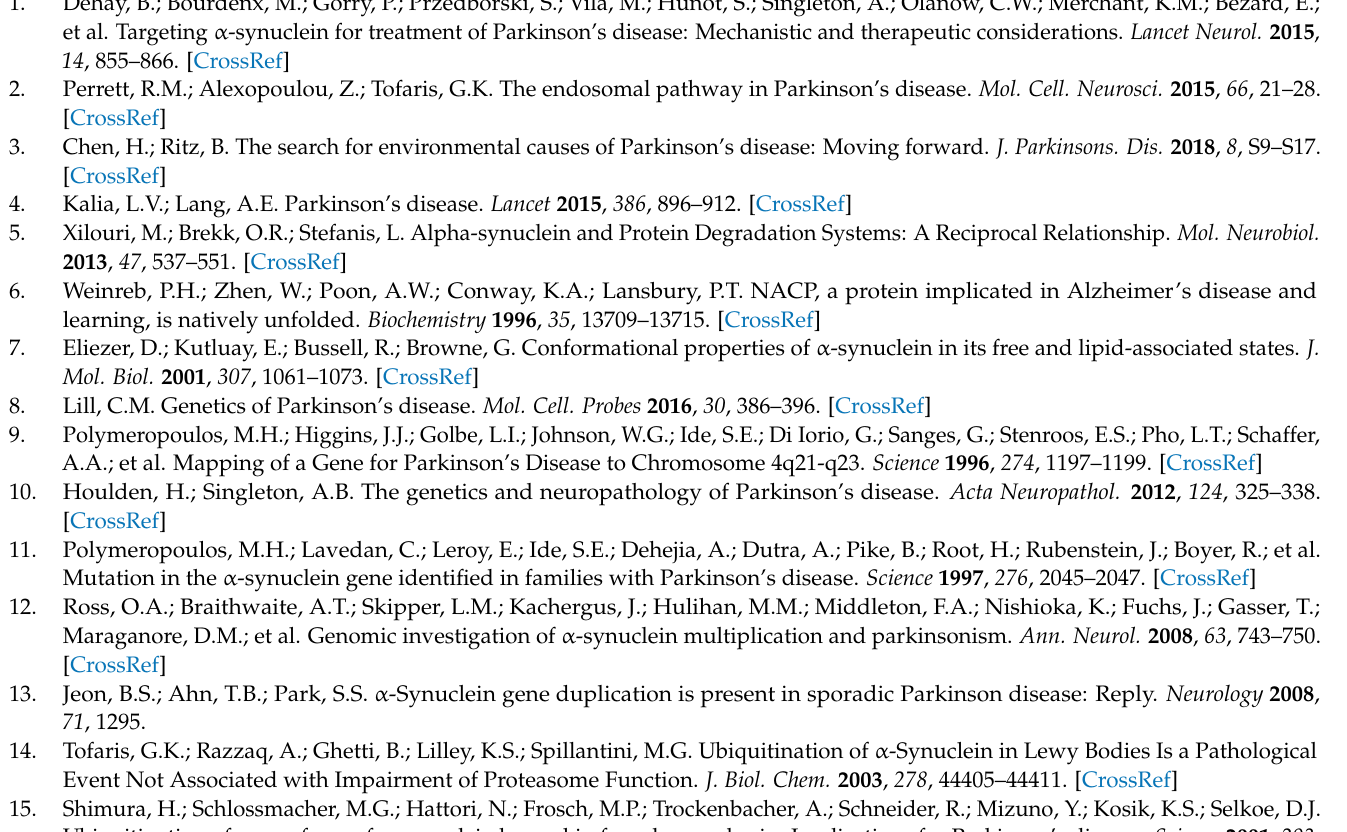
Figure S2: Upon differentiation hiPSCs express markers specific for NSCs, Supplementary Table S1: Oligonucleotides adopted to assess hiPSCs differentiation into NSCs by RT-PCR, Figure S3: Analysis of differentiation from NSC to DPs by immunostaining, Figure S4: Alpha-synuclein overexpression or mutation results in a significant increase of DP